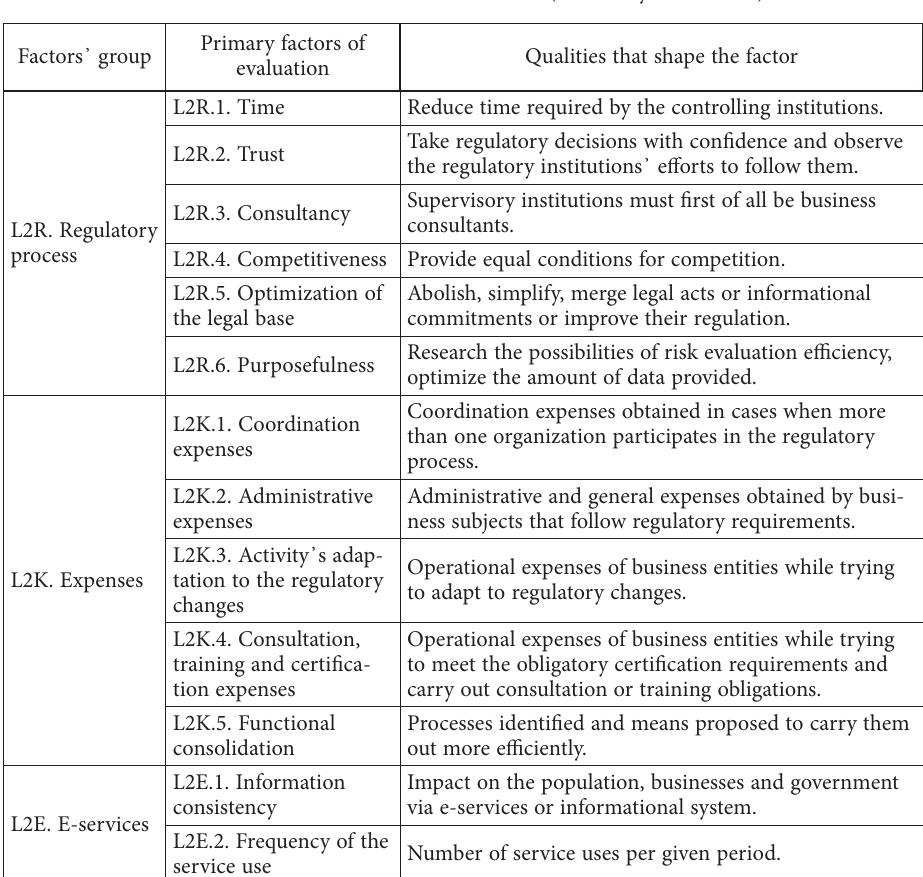
Qualities that shape the